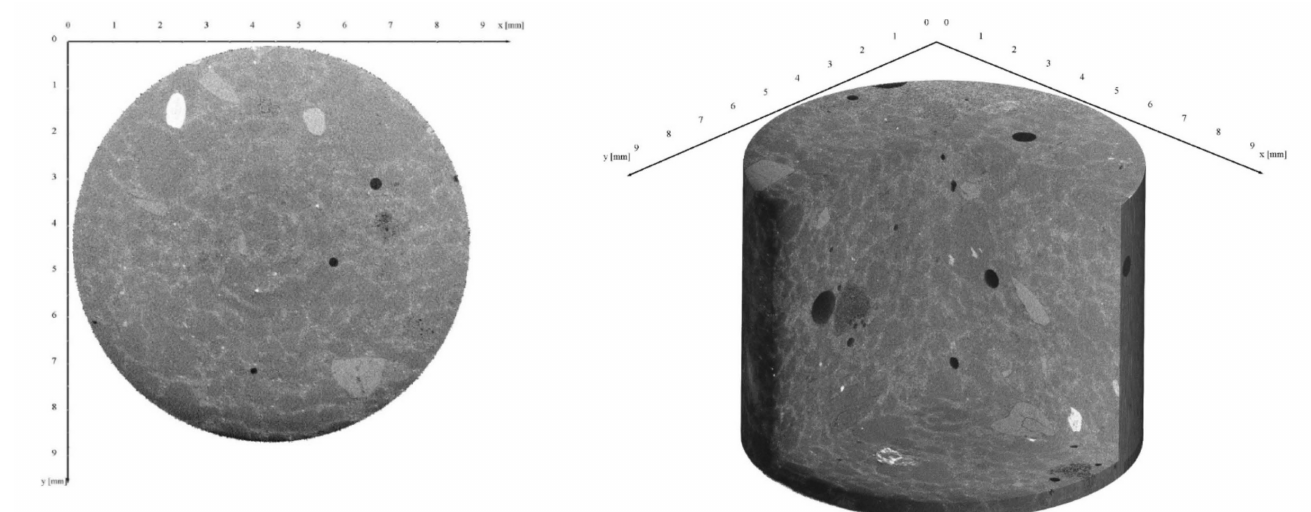
Figure 11. XRCT scan of HPC2-D in phase 0 (undamaged).